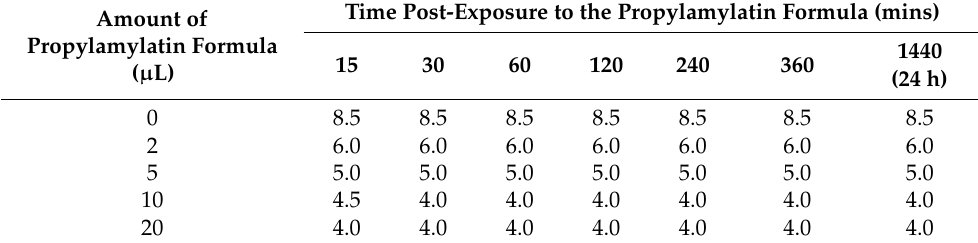
Table 2. The pH of tissue culture medium used to dilute SARS-CoV-2 at various times post-exposure to various volumes of Propylamylatin